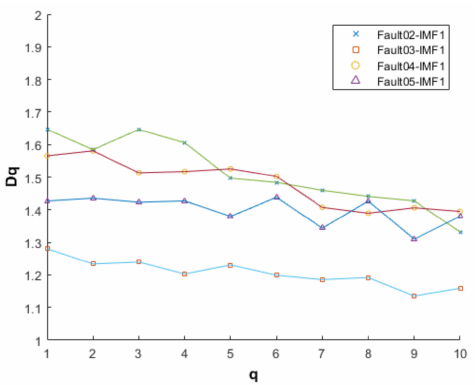
Figure 12. IMF1‑EMD mathematical morphology fractal dimension